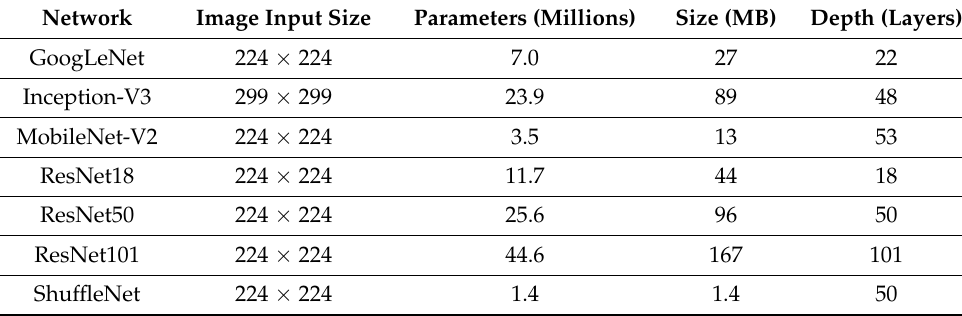
Figure 3. CNN architecture model. Table 2. Specifications of pre-trained models.